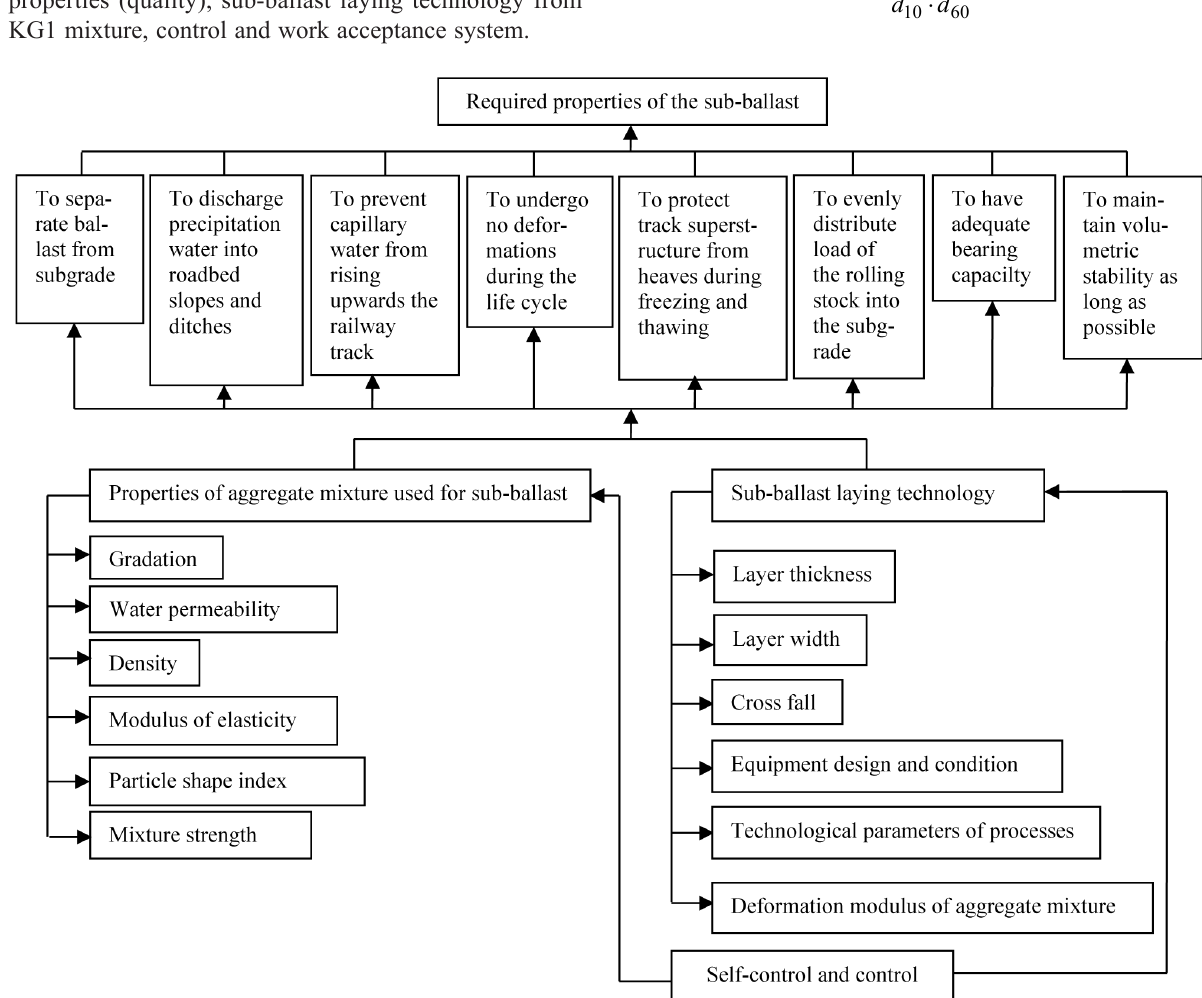
Fig. 2. Required properties of the sub-ballast and factors determining